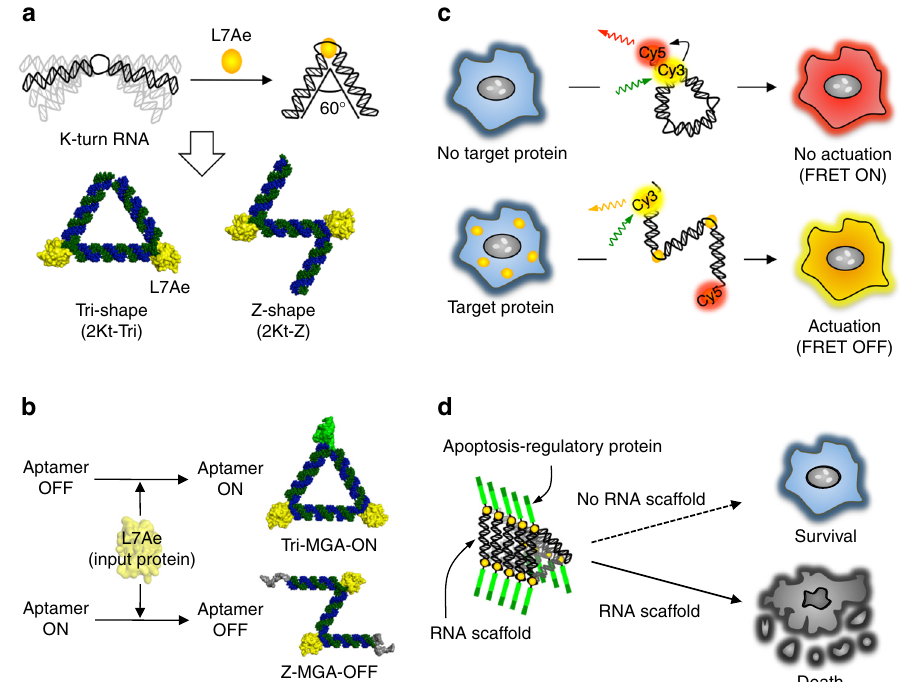
Fig. 1 Schematic illustration of protein-driven RNA nanodevices in vitro and in mammalian cells. a Protein-triggered conformational change in RNA due to the L7Ae-K-turn interaction ( top ) and three-dimensional modeling of the 2Kt-Tri and 2Kt-Z nanostructures ( bottom ). b Protein-driven RNA nanodevices that control RNA function in response to proteins. c Actuation of protein-responsive RNA nanodevices that control fl uorescence signals within cells. d Controlling apoptosis by regulating the assembly and oligomerization of apoptosis regulatory proteins on RNA